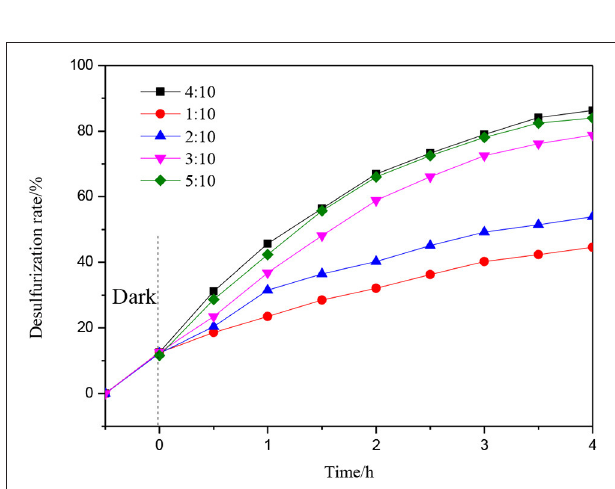
FIGURE 9 | Photocatalytic desulfurization efficiency with different mass ratio of 1%Er 3 + :CeO 2, and